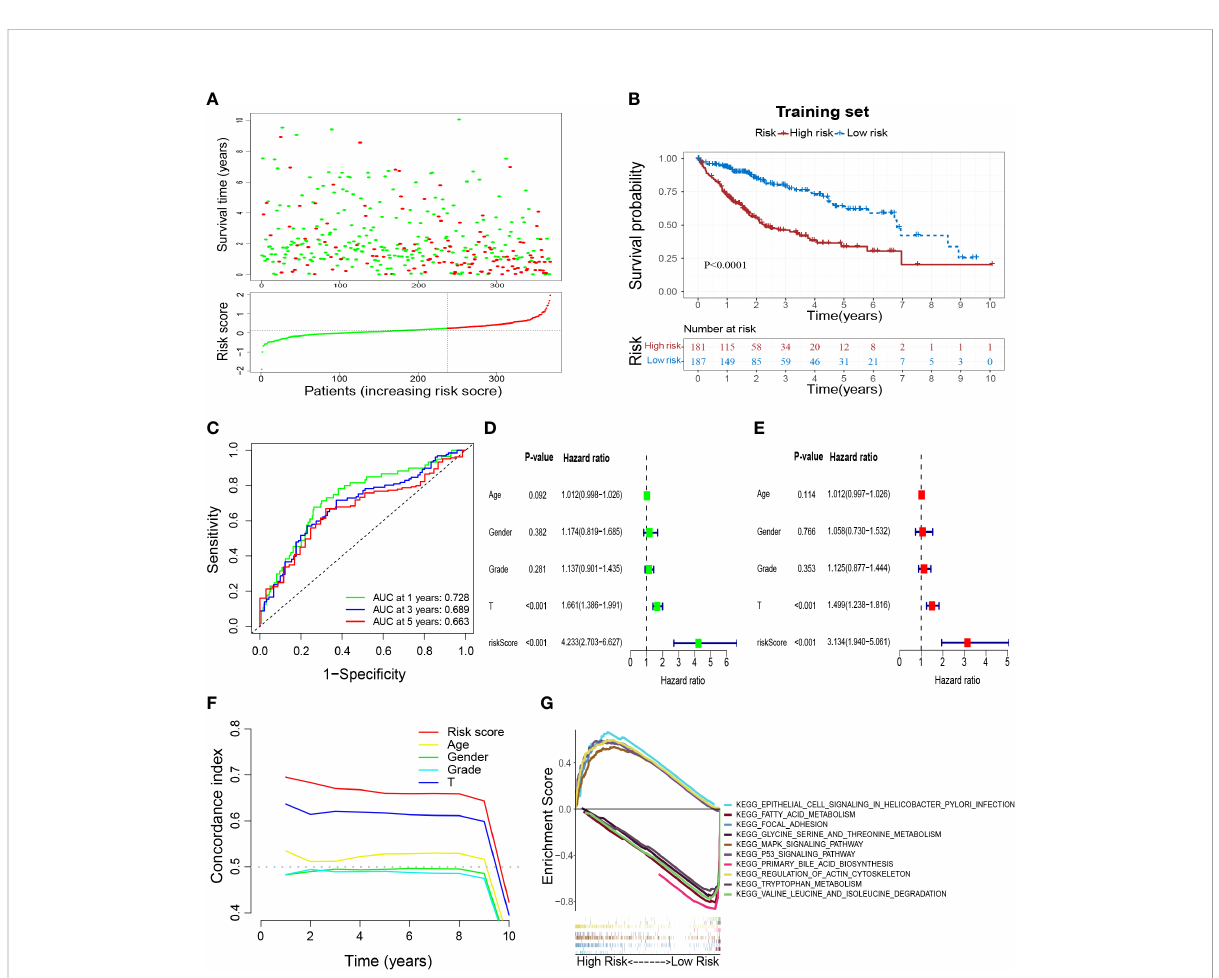
FIGURE 5 Construction of a M2-like TAM-related prognostic signature. (A) Survival status and risk scores of HCC patients in high- and low-risk groups in the training set. Green dots denote low risk and red dots denote high risk. (B) Kaplan – Meier survival curves showed a signi fi cantly worse prognosis for the high-risk group in the training set. (C) ROC curves for 1, 3, and 5 years and their AUCs. (D – F) The results of univariate analysis, multivariate analysis, and C-index indicated that risk score was an independent risk factor in fl uencing survival status in preference to other indicators. (G) Results of GSEA analysis. TAM, tumor-associated macrophage; HCC, hepatocellular carcinoma; ROC, receiver operator characteristic; AUC, area under curve; C-index, Concordance index; GSEA, gene set enrichment